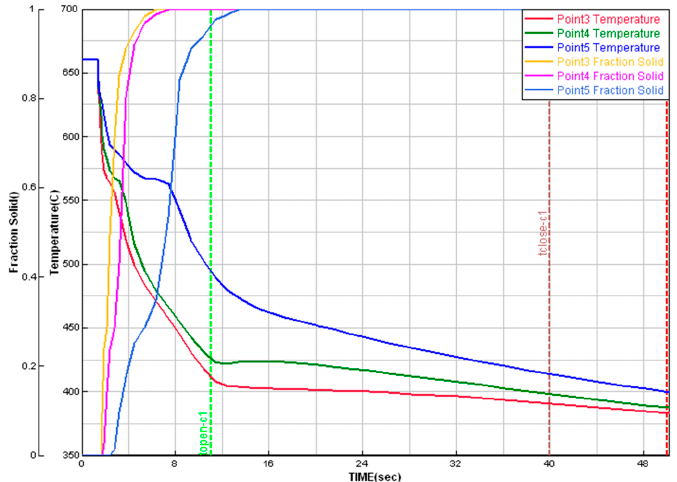
Figure 6. Simulated cooling curves and fraction solids in samples with different wall thicknesses (ProCAST).